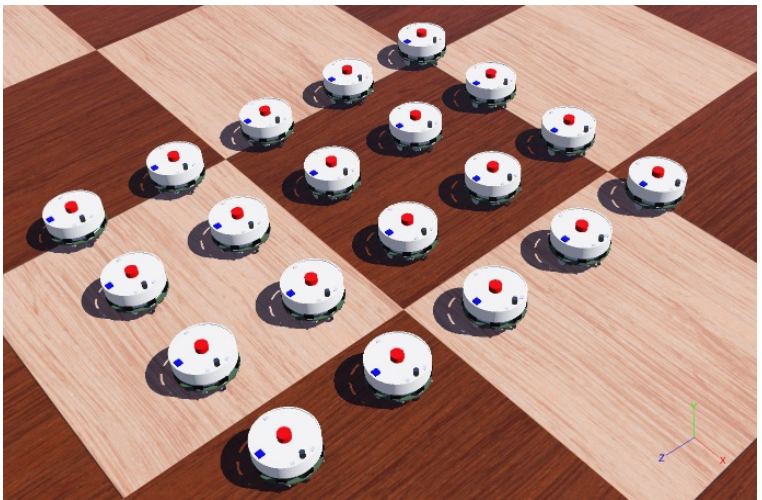
Figure 16. Elisa-3 robot swarm in Webots simulator.